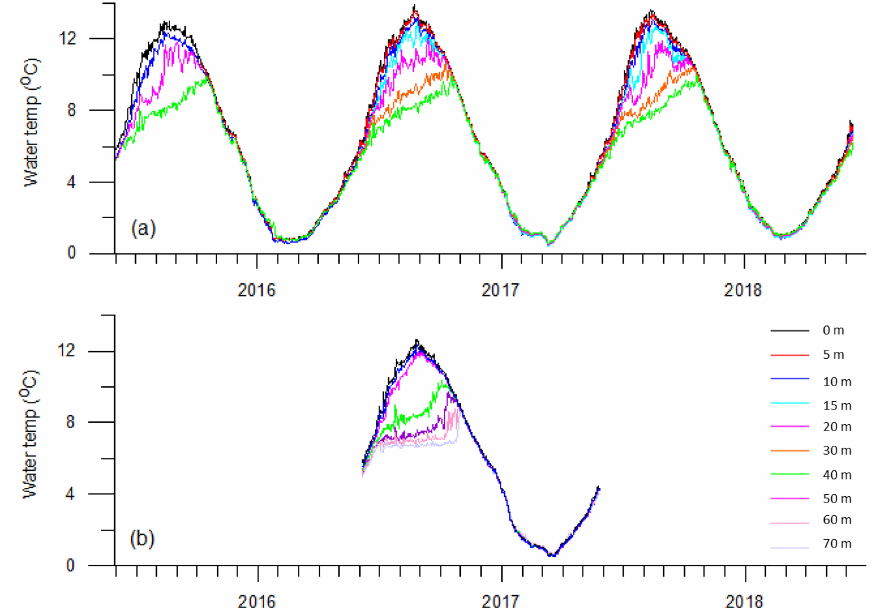
Figure 2. Time series of daily lake water temperature at different water depths in Paiku Co’s southern (a) and northern (b)